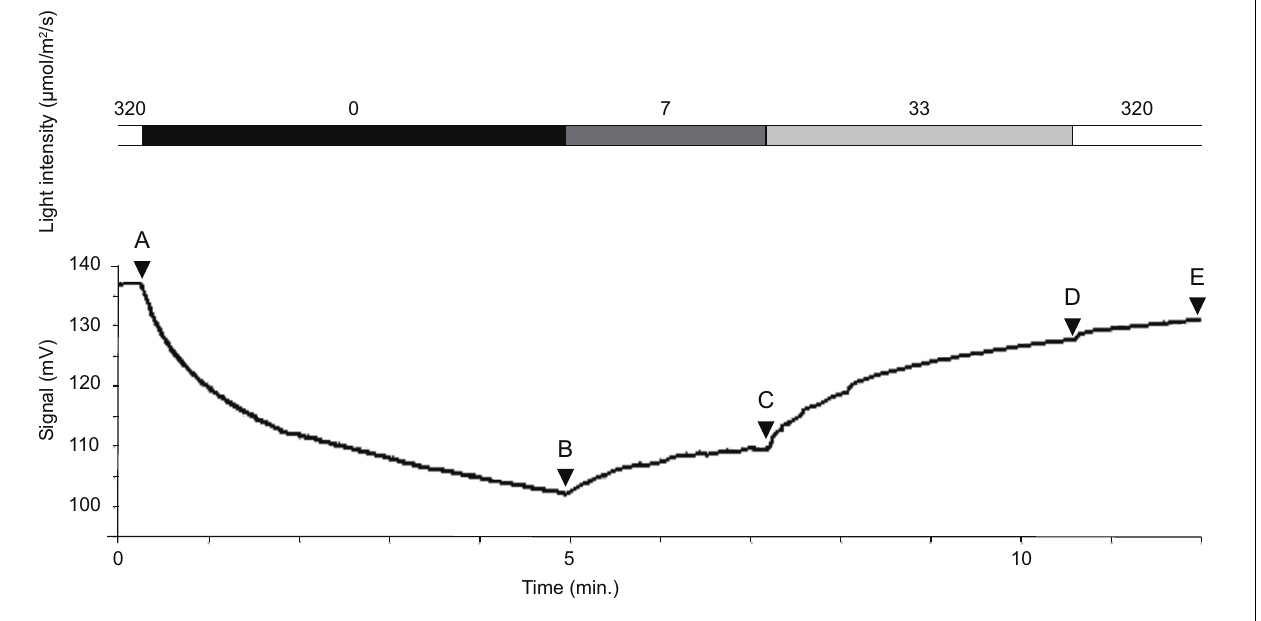
FIGURE 7 | Oxygen concentration changes rapidly in response to light intensity. Oxygen concentration (mmol L − 1 ) shown in Table 2 . Intensity of light quantum ( µ mol/m 2 /s): 320 (A) , 0 (B) , 7 (C) , 33 (D) , and 320 (E)